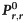
Detection rates against Pr,r0 for count communication data with |V| = 100 with four communities.P1,1′=(1+0.5)×P1,10.